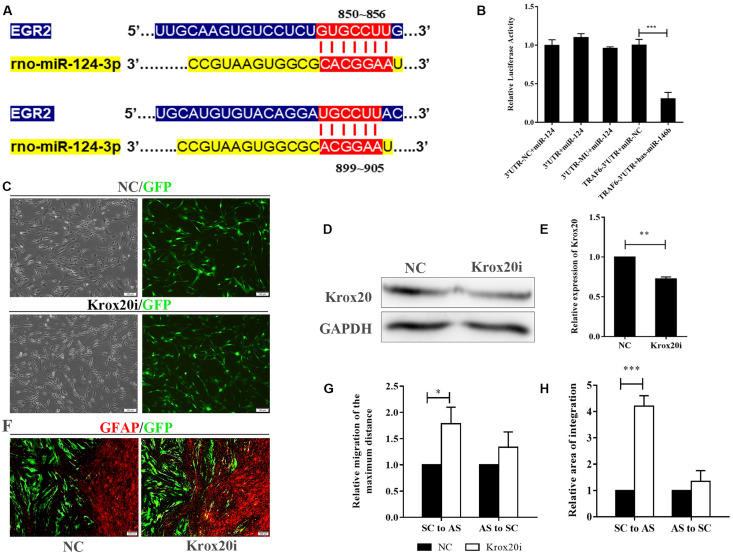
MiR-124 overexpression enhanced SC-AS integration through indirect regulation of Krox20. (A) Bioinformatic websites predicted that Krox20 (Egr2) and rno-miR-124-3p had two binding sites at 850 ∼ 856 and 899 ∼ 905. (B) MiR-124 did not bind to 3′UTR of Krox20 according to the dual luciferase assay. Positive control (TRAF6-3′UTR + has-miR-146b) showed no problems in the detection system (n = 3, p > 0.05, ***p < 0.001). (C) Lentivirus of Krox20-interference vectors (Krox20i) were applied to knockdown Krox20 expression in SCs (scale bar = 100 μm). (D,E) The efficiency of interference was analyzed by western blotting, and the results showed that the Krox20 expression was down-regulated by Krox20i (n = 3, **p < 0.01). (F) The SC-AS integration was observed by immunofluorescence. The results showed the increased ability of SC-AS integration after Krox20 was down-regulated (scale bar = 100 μm). (G) The relative migration of the maximum distance of SCs into the astrocytic region was higher after Krox20 interference in SCs (n = 3, *p < 0.05). The migration of ASs was not affected. (H) The relative migration area of SCs was significantly higher after Krox20 interference in SCs (n = 3, ***p < 0.001). The integration ability of ASs did not significantly change.